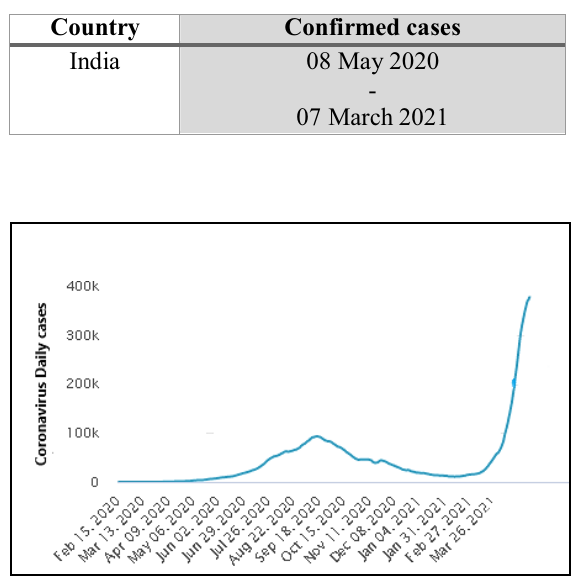
Table 2. Selection of data for experimentation.